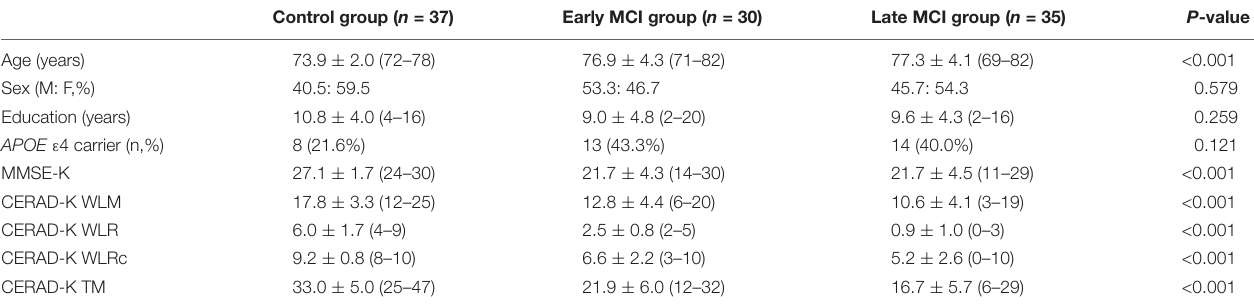
TABLE 1 | Demographic and clinical characteristics of the study